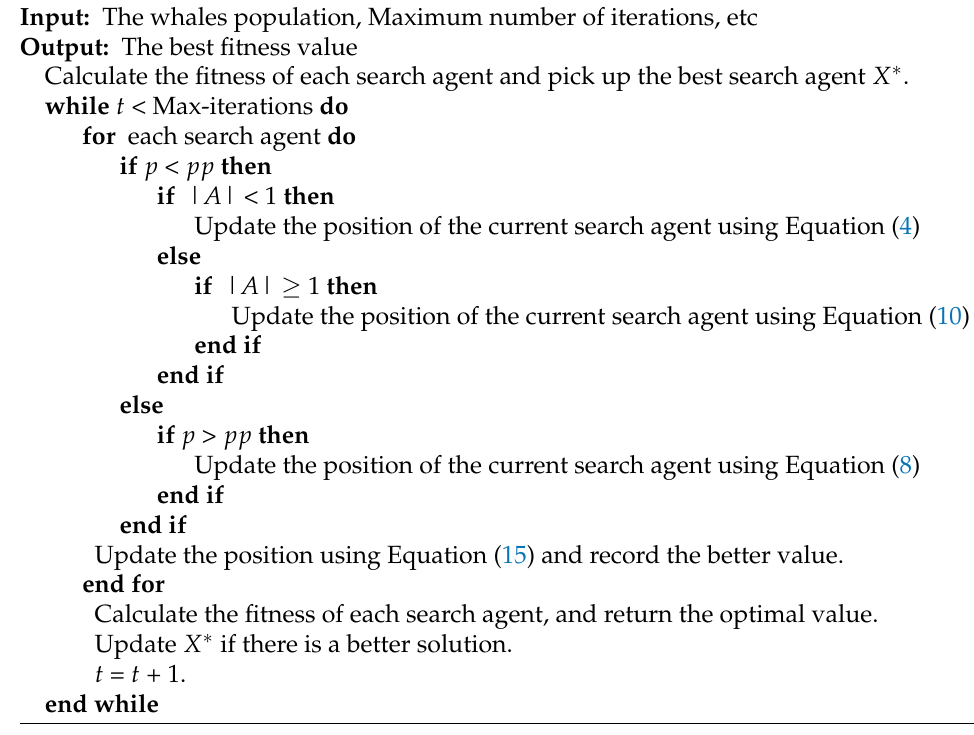
Algorithm 1 Improved whale optimization algorithm